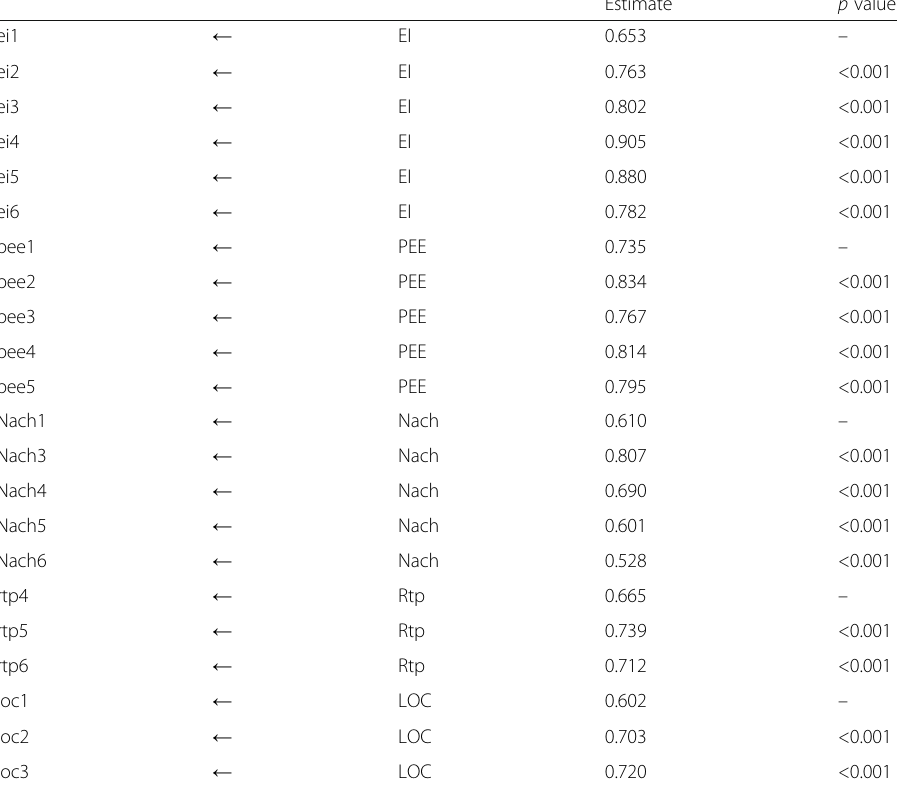
– indicates the statistic was not calculated due to parameter constraint Ei entrepreneurial goal intention, pee effects of entrepreneurship education, nach need for achievement, rtp risk-taking propensity, loc internal locus of